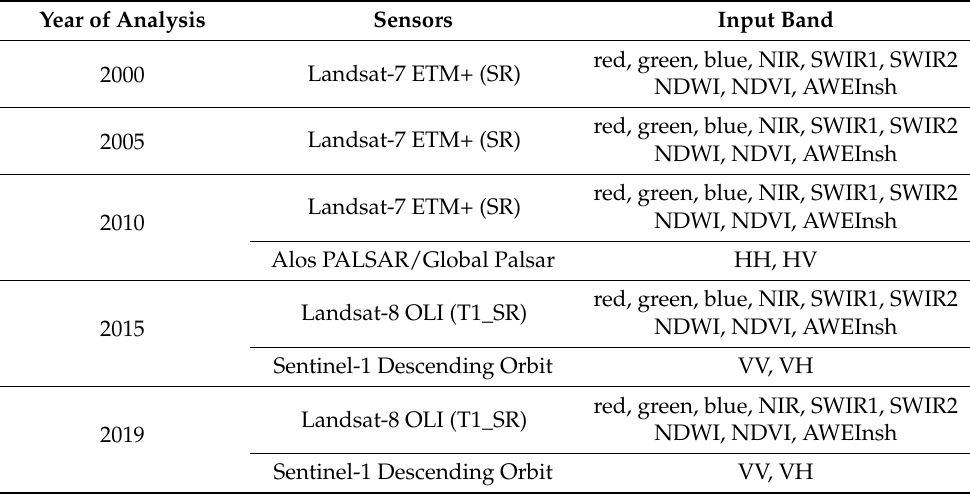
Table 1. Variables from remote sensing data used for